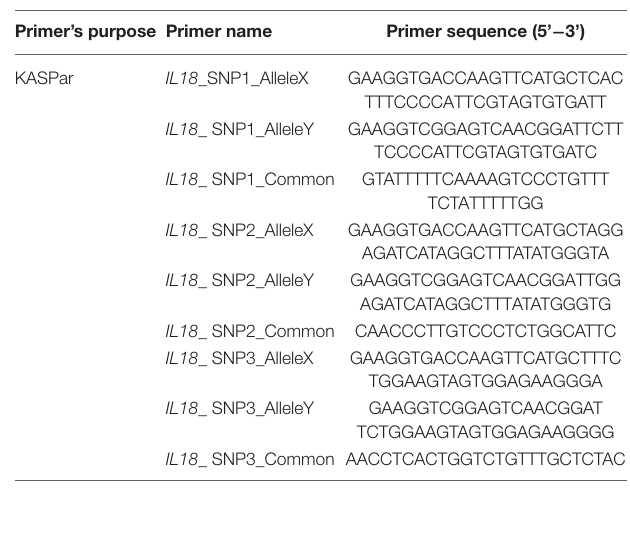
TABLE 2 | Primers used for KASP